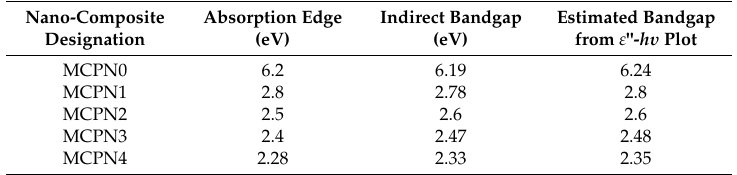
Figure 3. The absorption coefficient spectra against h υ for pure MC and doped MC films. Table 1. Absorption edge and optical bandgaps for MC and doped MC samples.